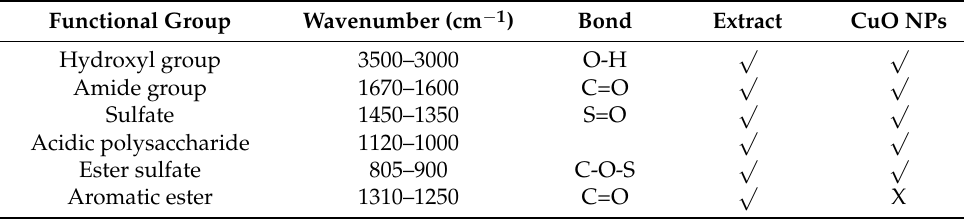
Table 2. Main functional groups of the algal extract and copper oxide